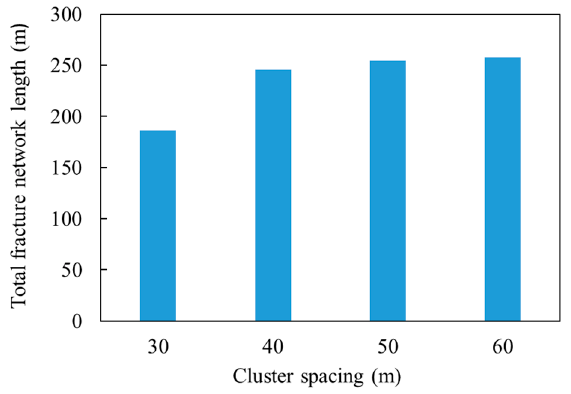
Figure 10. Effect of cluster spacing on hydraulic fracture propagation. ( a ) Cluster spacing = 30 m; ( b )